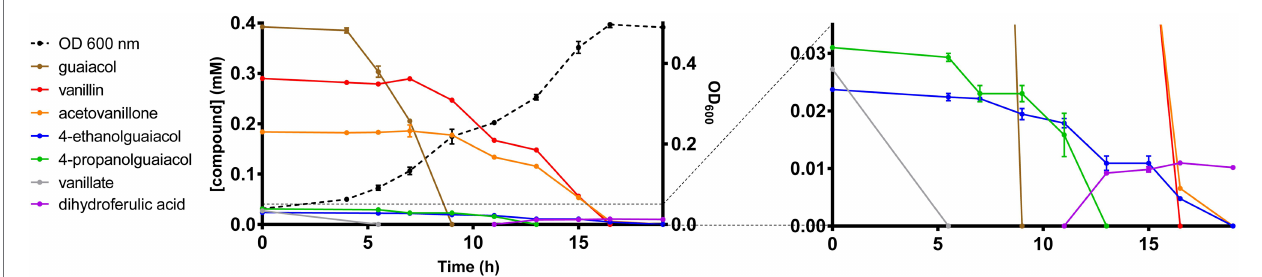
FIGURE 5 | Growth of GD02 on a mixture of black liquor aromatic compounds. GD02 was grown at 30 ° C in defined medium with a mixture of aromatic compounds in the same proportions as in the BL acetone extract, total concentration 1 mM. Compounds were measured in the culture supernatant using GC-MS analysis. Data points represent the average of triplicate experiments and the error bars the SD. The panel on the right depicts the compounds present at lower concentrations.